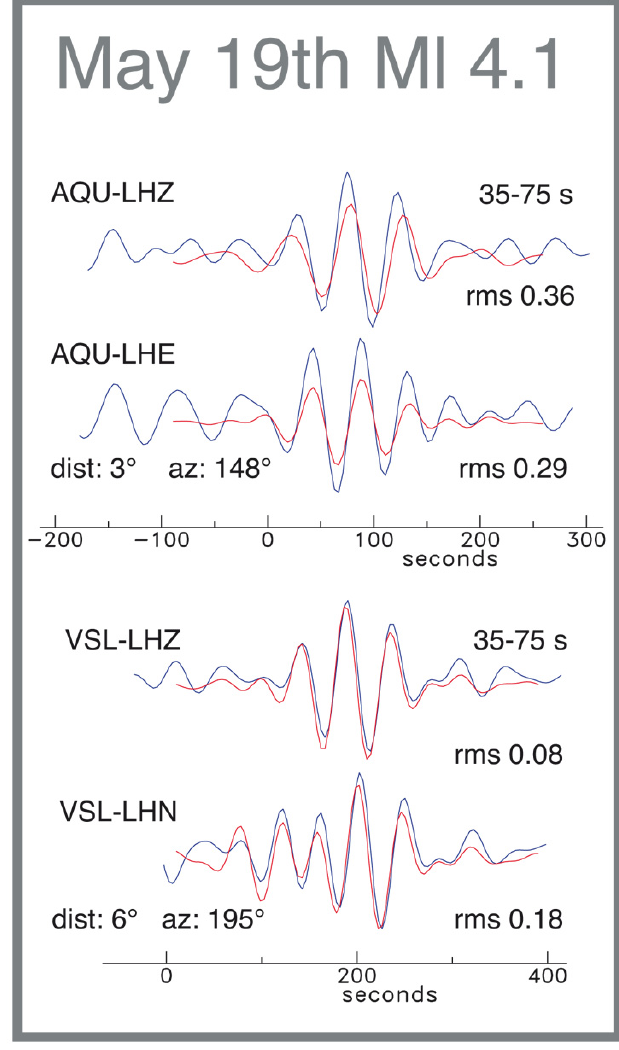
Figure 3. Examples of waveforms (blue) and synthetics (red) used for the QRCMT computations. Left: examples for the May 20, 2012, M Right: examples for the May 19, 2012, M